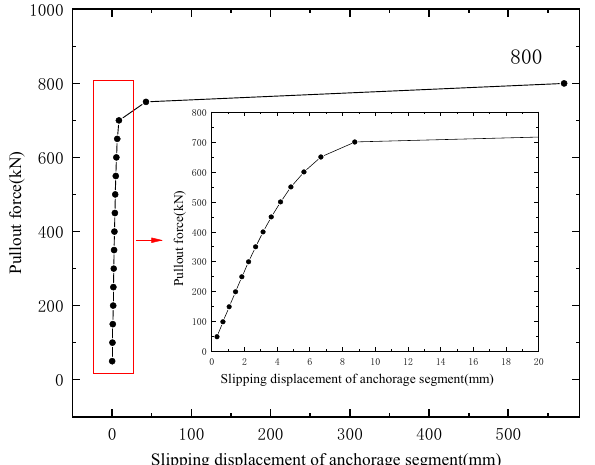
Figure 15. Curve representing relationship between pullout force and slipping displacement.